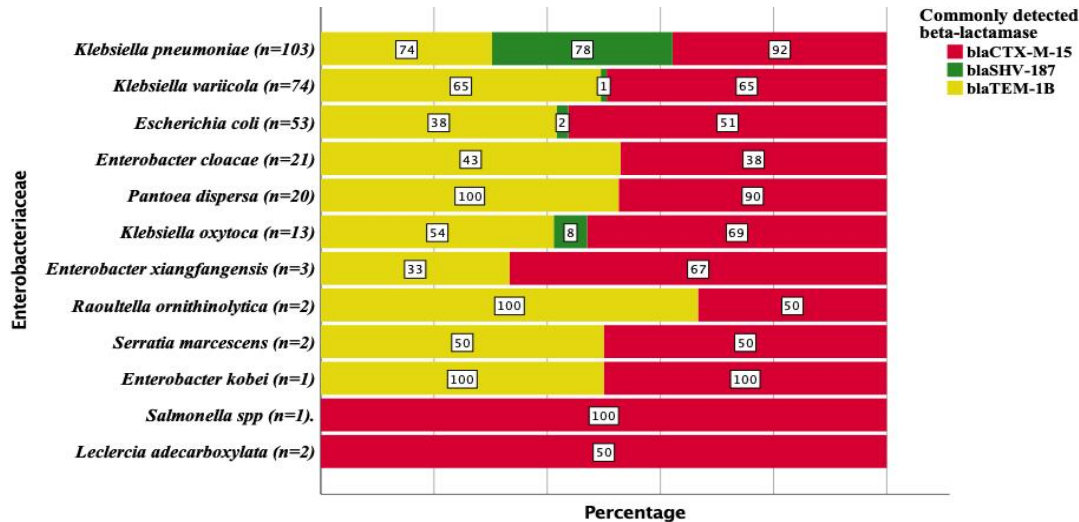
Figure 4. Frequency and distribution of bla SHV-187 , bla CTX-M-15 and bla TEM-1B that were detected frequently among Enterobacteriaceae. 2.6. Non-ESBL β -lactamase Variants of bla TEM and bla SHV